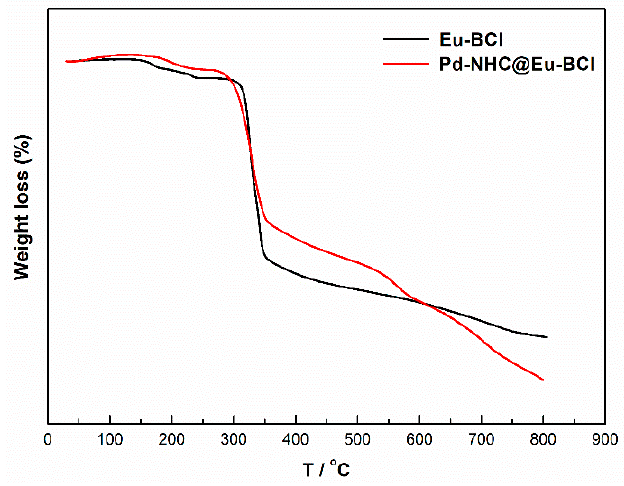
Figure 2. TGA plots of Eu-BCI and Pd-NHC@Eu-BCI.